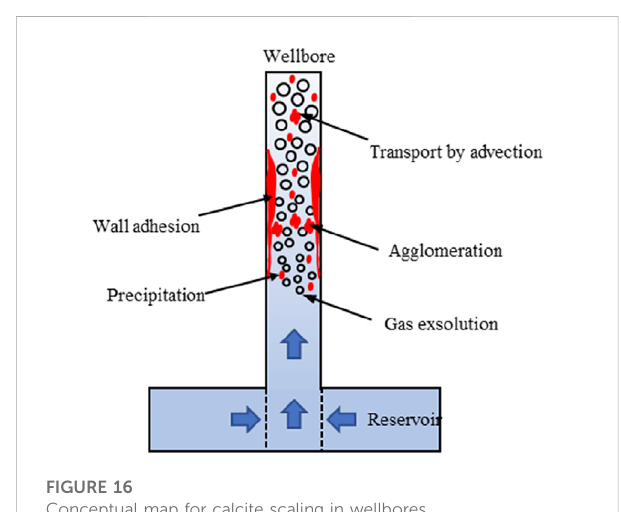
FIGURE 16 Conceptual map for calcite scaling in